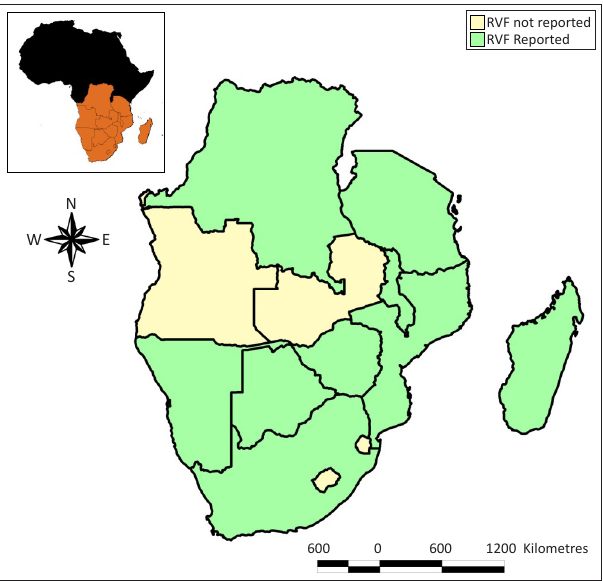
Countries which reported Rift Valley fever are indicated green and those that have not reported are indicated yellow. RVF, Rift Valley fever. FIGURE 4: Map showing the occurrence of Rift Valley fever in the Southern Africa Development Community region in the period